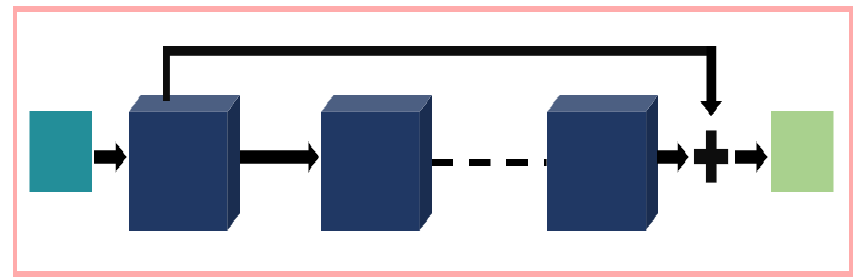
Figure 3. Residual module for our network.